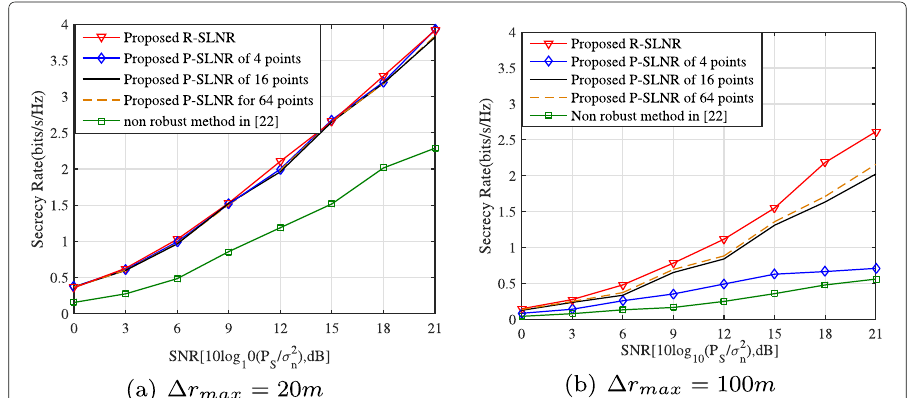
Fig. 9 Curves of secrecy rate versus SNR(10 log 10 ( P /σ 2 n ) ) of the proposed methods with (cid:7) r max = 20 m and = 100 (cid:7) r max